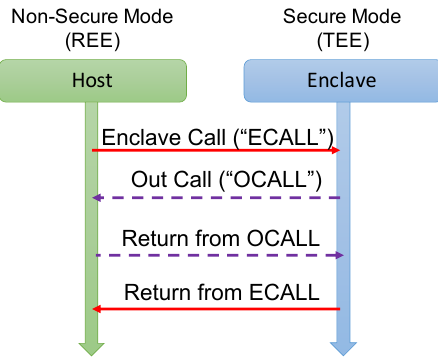
Figure 8. Interaction between Host and Enclave by using